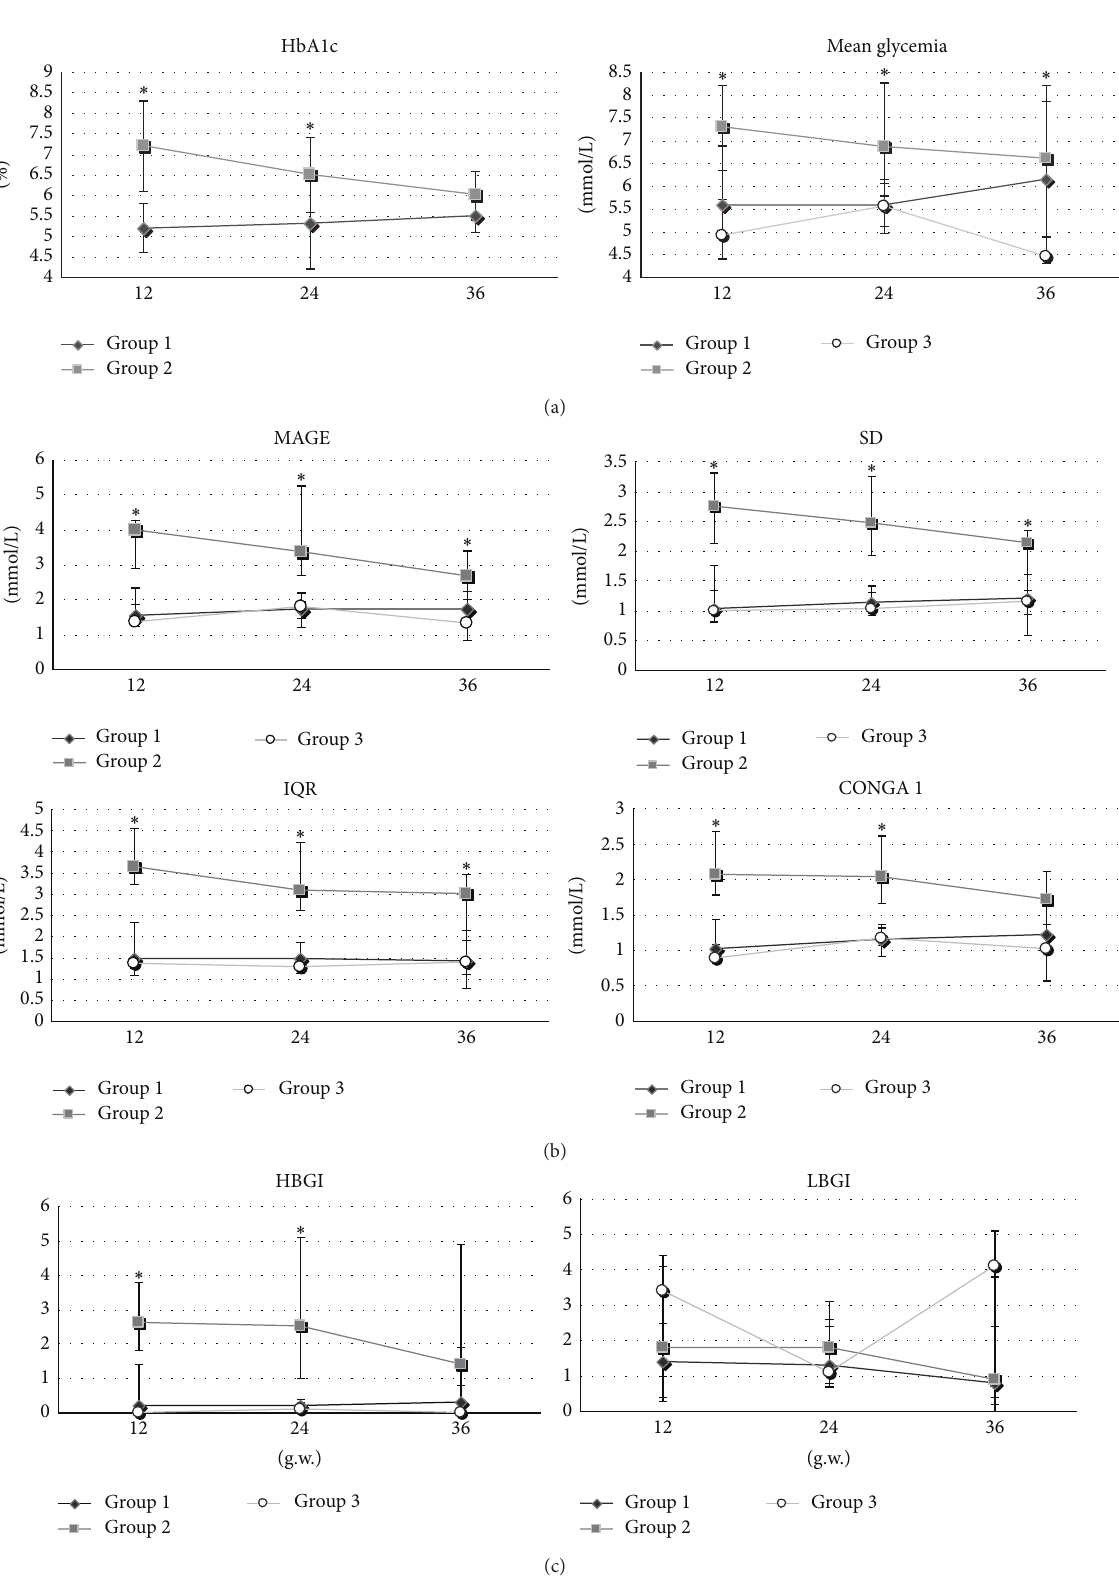
Figure 1: Trend in the three trimesters of pregnancy of indicators of average glycemic control (a), glucose variability (b) and hypohyperglycemic risk (c) in cases of gestational diabetes (Group 1), type 1 diabetes (Group 2) and healthy pregnant women (Group 3). MAGE, mean amplitude of glycemic excursions; SD, standard deviation; IQR, interquartile range; CONGA, continuous overlapping net glycemic action; HBGI, high blood glycemic index; LBGI, low blood glycemic index. Mean value, MAGE, SD, IQR, CONGA 1 are expressed inmg/dL;HbA1cexpressedin%;LBGIandHBGIareexpressedinclassesofrisk. ∗ StatisticalsignificanceofANOVAamonggroupsconsidered for 𝑃 < 0.05